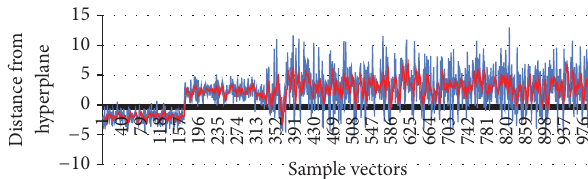
Figure12:StatedriftofTOM(T).Thisshowsaclearshiftfrom “bad” process performance to “good” at approx. sample 170.